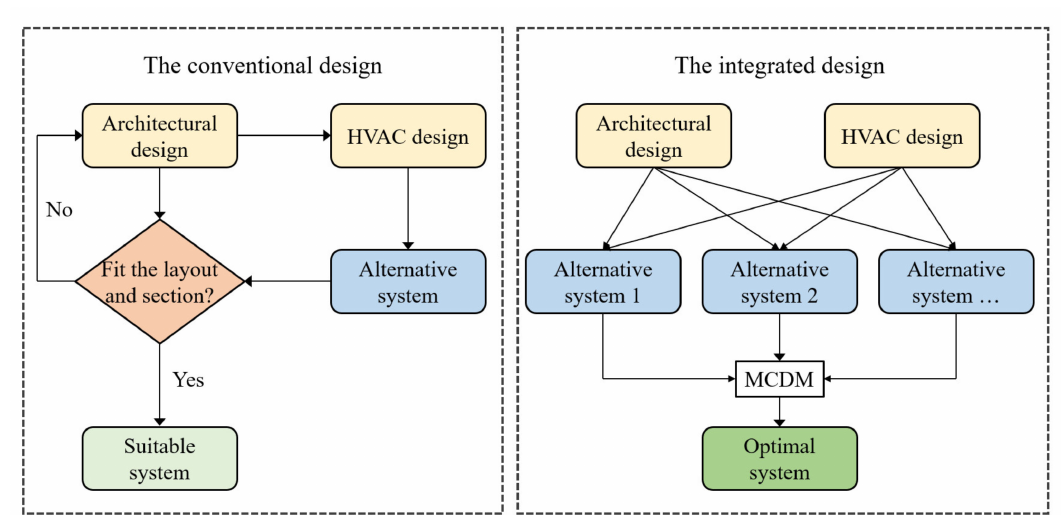
Figure 1. The conventional design and the assessment-based integrated